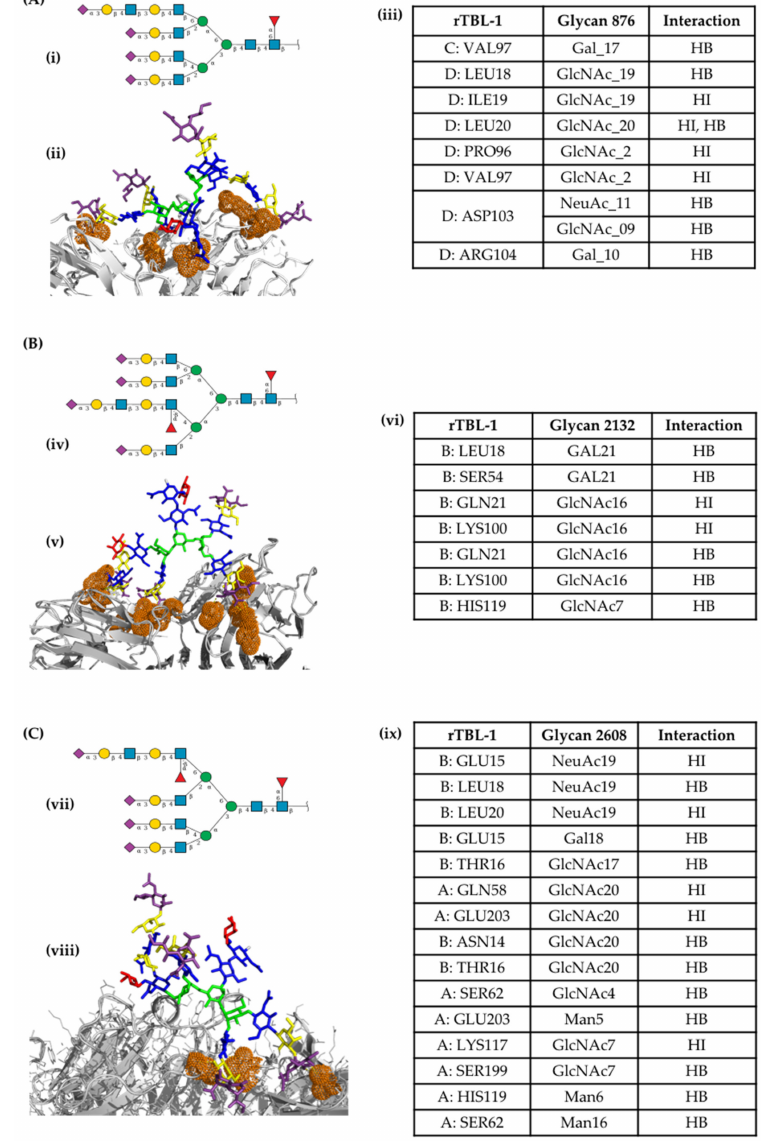
Figure 9. Molecular docking of recombinant Tepary bean lectin (rTBL-1) with EGFR-related glycans. ( A ) (i) Bidimensional representation of 876 N-glycan. (ii) Tridimensional representa- tion of the interaction between 867-N-glycan and rTBL-1. (iii) Table with docking-interacting residues. ( B ) (iv) Bidimensional representation of 2132 N-glycan. (v) Tridimensional represen- tation of the interaction between 2132-N-glycan and rTBL-1. (vi) Table with docking-interacting residues. ( C ) (vii) Bidimensional representation of 2608 N-glycan. (viii) Tridimensional represen- tation of the interaction between 2608-N-glycan and rTBL-1. (ix) Table with docking-interacting residues. N-glycans are presented as sticks colored according to the symbol nomenclature for glycans (SNG) [46]. The rTBL-1 structure is shown as white ribbons, and interacting residues are highlighted with orange dots. The graphical 2D representation of the N-glycans structure is shown accord- ing to SNG. HI—Hydrophobic interaction. HB—Hydrogen bond. GlcNAc—N-Acetylglucosamine. Gal—Galactose. NeuAc—N-acetylneuraminic